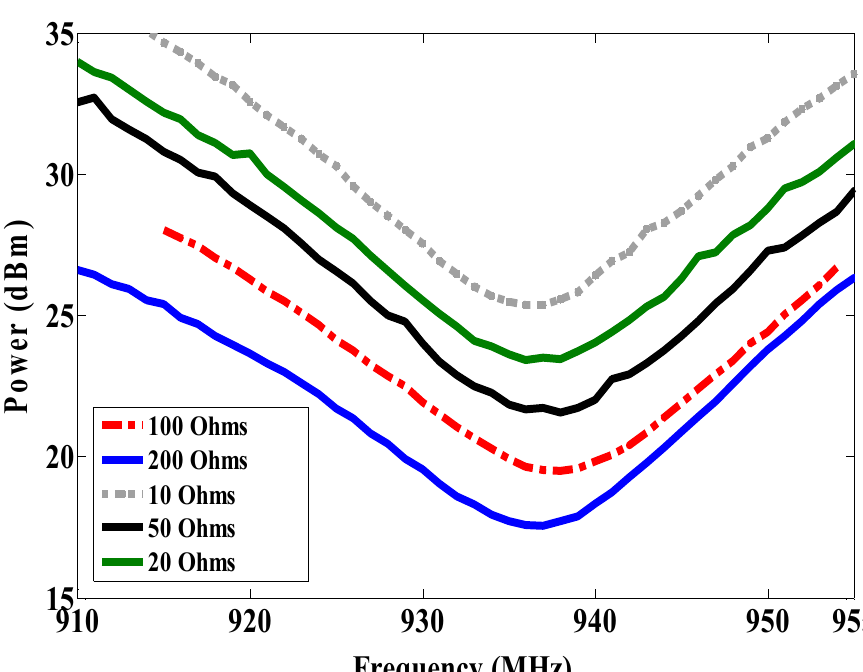
Figure 10. Measured minimum required power to activate sensor node with different resistance (antenna B).